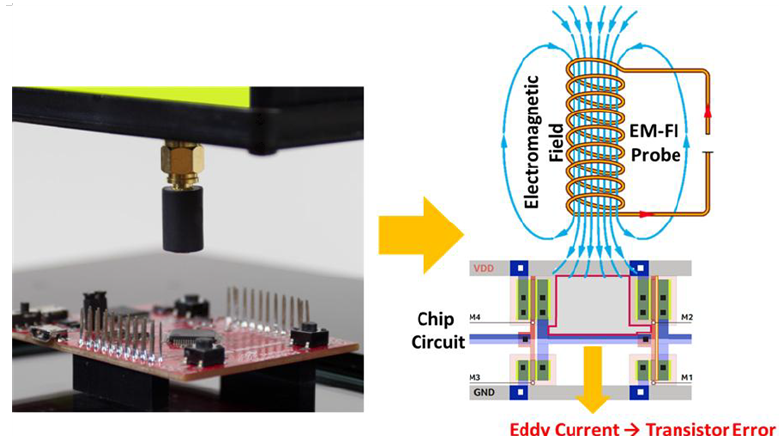
Figure 1. Principle of electromagnetic fault